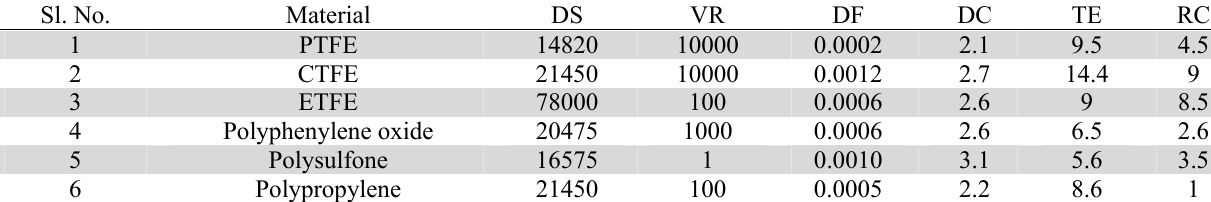
Decision matrix for insulation material for computer cables (Jahan et al., 2012) Sl. No.